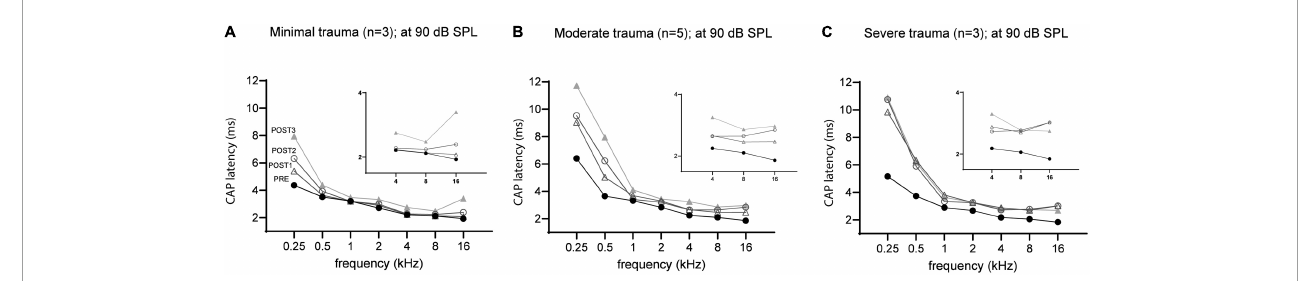
FIGURE10 The mean CAP latencies at 90 dB SPL of the three trauma groups are shown for all stages, with insert graphs highlighting the differences at the higher frequencies (4–16 kHz). The PRE values were comparable between the three groups. In addition to high frequencies (4–16 kHz), the lower frequencies (0.5–2 kHz) were also affected in all three groups. The minimal trauma group had the lowest latency shifts (A) , followed by the moderate trauma group (B) , and the highest shifts were observed for the severe trauma group (C) .